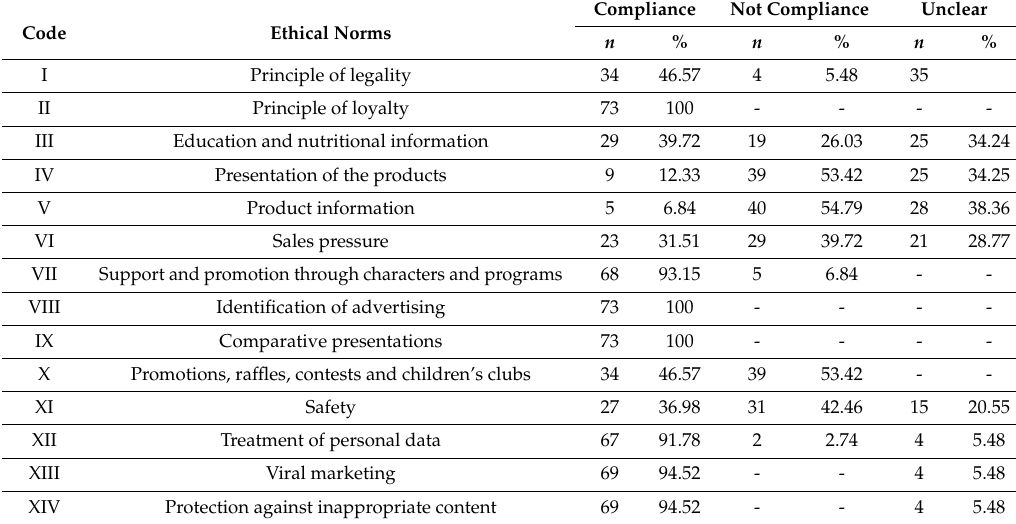
Table 1. PAOS Code compliance and its ethical norms on mobile devices in Spain,